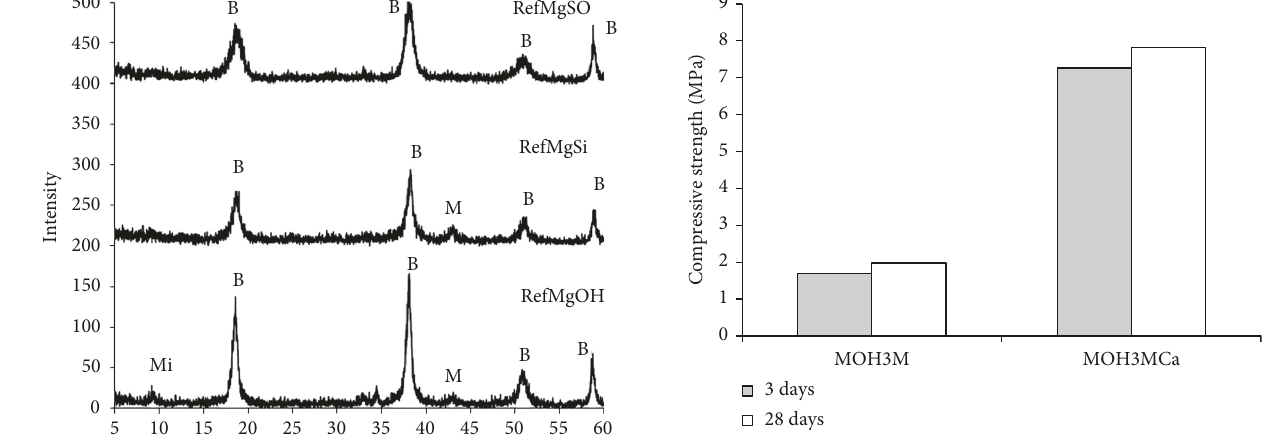
Figure 5: Effects of calcium hydroxide on strength development of limestone/metakaolin system activated with sodium hydroxide.